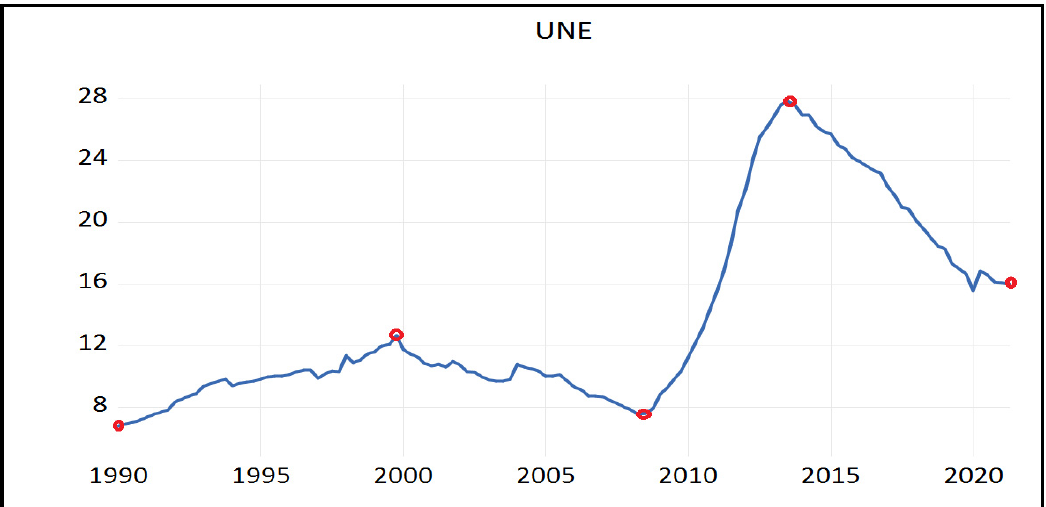
Figure 1. Seasonal Data for Unemployment.